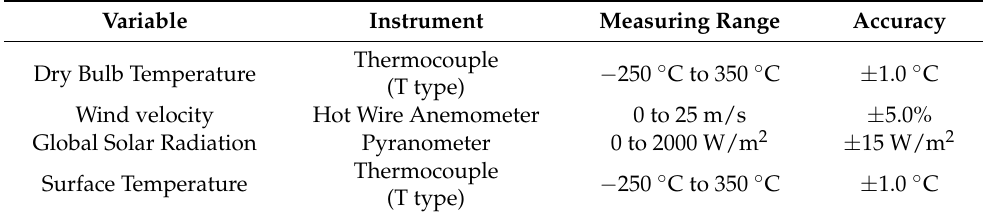
Figure 3. ( a ) Measured inside surface temperature; ( b ) measured internal and external air tempera- tures; ( c ) measured GHI (global horizontal irradiance); and ( d ) measured wind speed. Table 1. Measurement equipment specifications used in the measurement